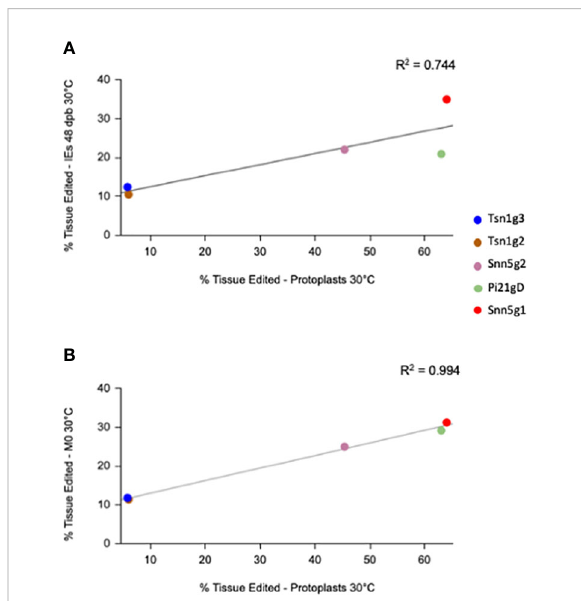
FIGURE 4 Correlation plot between targeted editing ef fi ciency of gRNA-